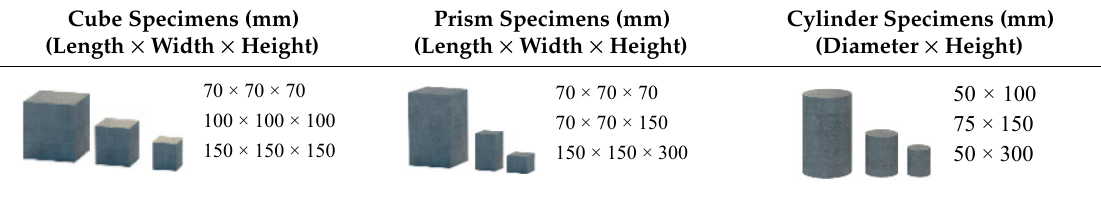
Table 1. Concrete specimens made in the uniaxial and compressive experiment. Cube Specimens (mm) Prism Specimens (mm) Cylinder Specimens (mm) (Length × Width × Height) (Length × Width × Height) (Diameter × Height)